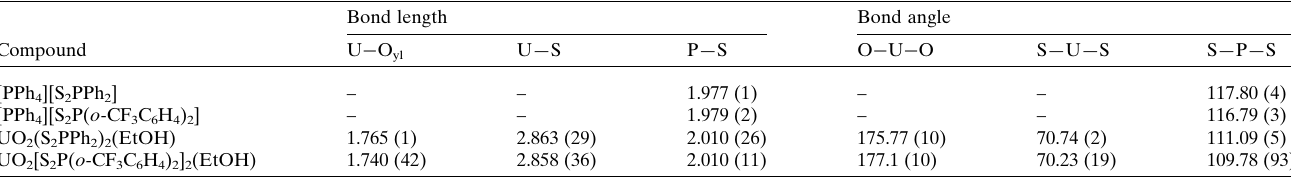
Table 1 Selected bond lengths (A˚ ) and bond angles ( (cid:4) ) for [PPh 4 ][S 2 P R 2 ] and UO 2 (S 2 P R 2 ) 2 (EtOH) in the crystal structures. Bond length Bond angle Compound